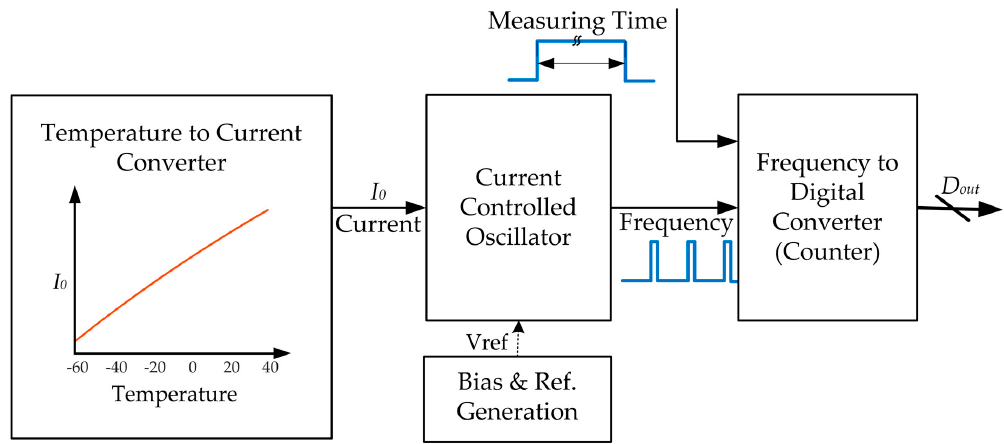
Figure 1. Block diagram of the temperature sensor.